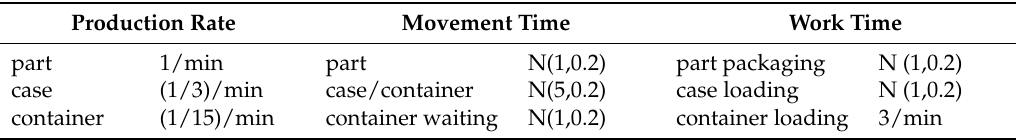
Table 3. Simulation variables. (unit: min)